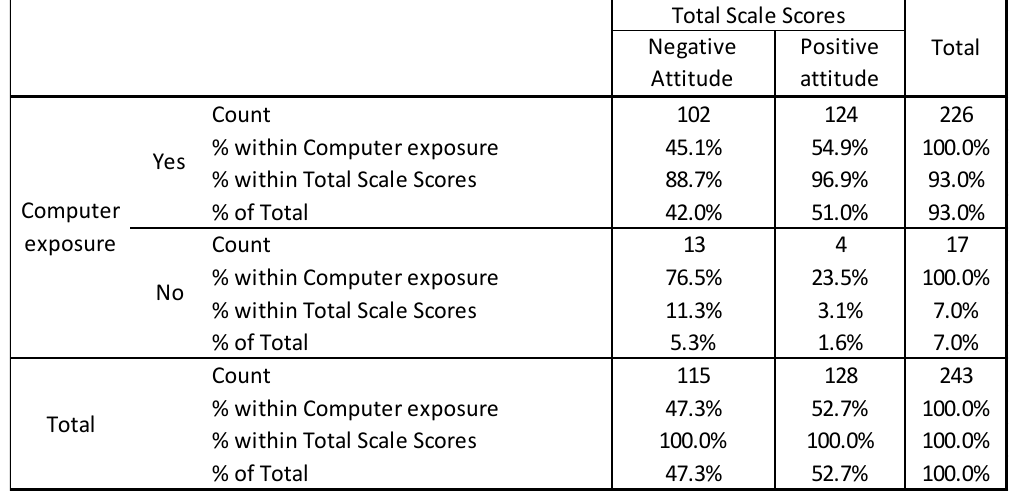
Computer Exposure and Attitude Towards